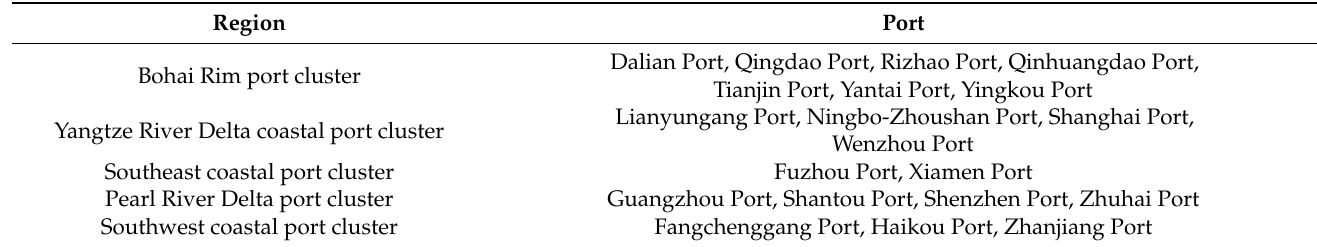
Table 5. Based on this, the difference in logistics efficiency of coastal ports was explored. The five major regional divisions.